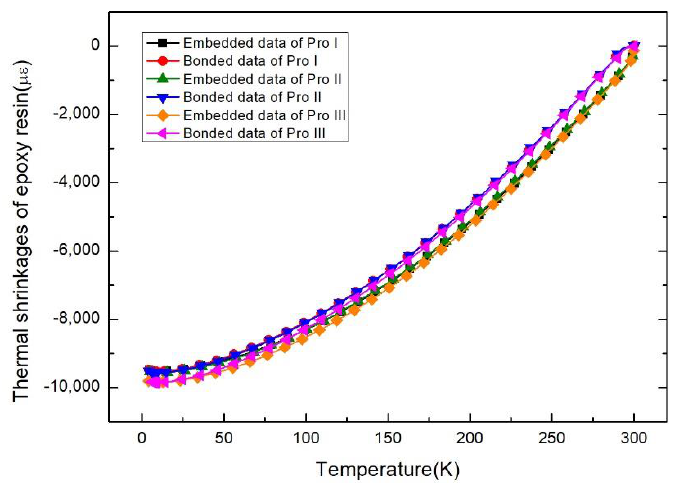
Figure 8. Thermal shrinkages of epoxy resin during cooling down to cryogenic temperature with three curing processes.